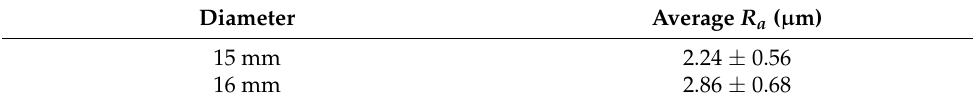
Table 2. The average surface roughness after ultrasonic cavitation peening.